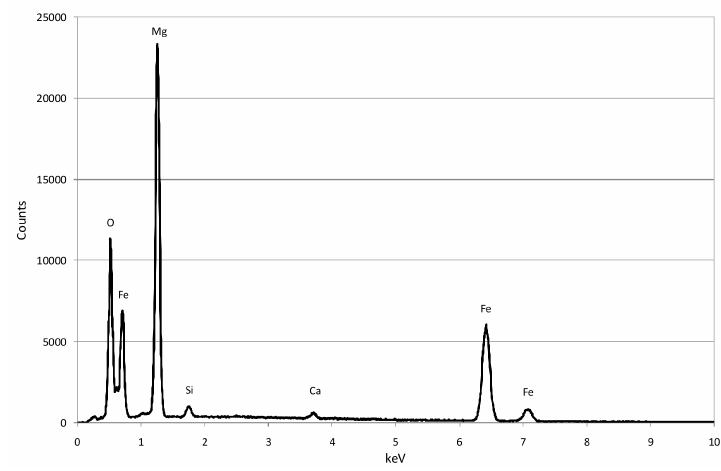
Figure 4. EDS spectrum of MgO_nZVI particles.